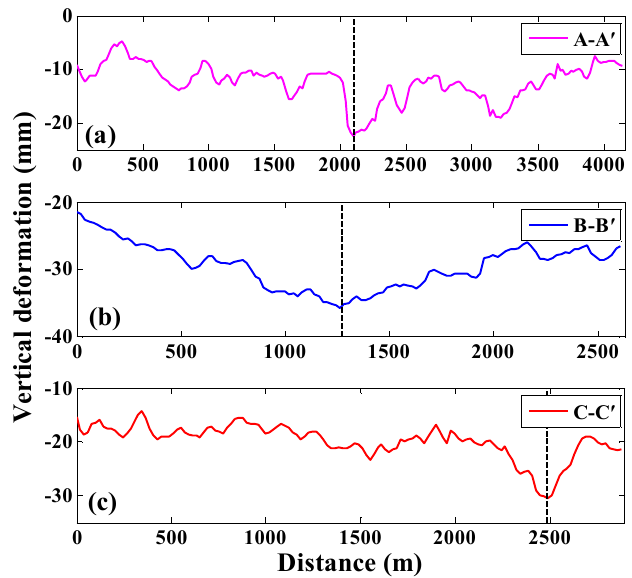
Figure 11. ( a – c ) Variation in accumulated subsidence (in the vertical direction) during the period from 11 April 2015 to 29 April 2016 along profiles A-A ′ , B-B ′ , and C-C ′ (in Figure 10). Black dotted lines mark locations of the largest accumulated subsidence of profiles.